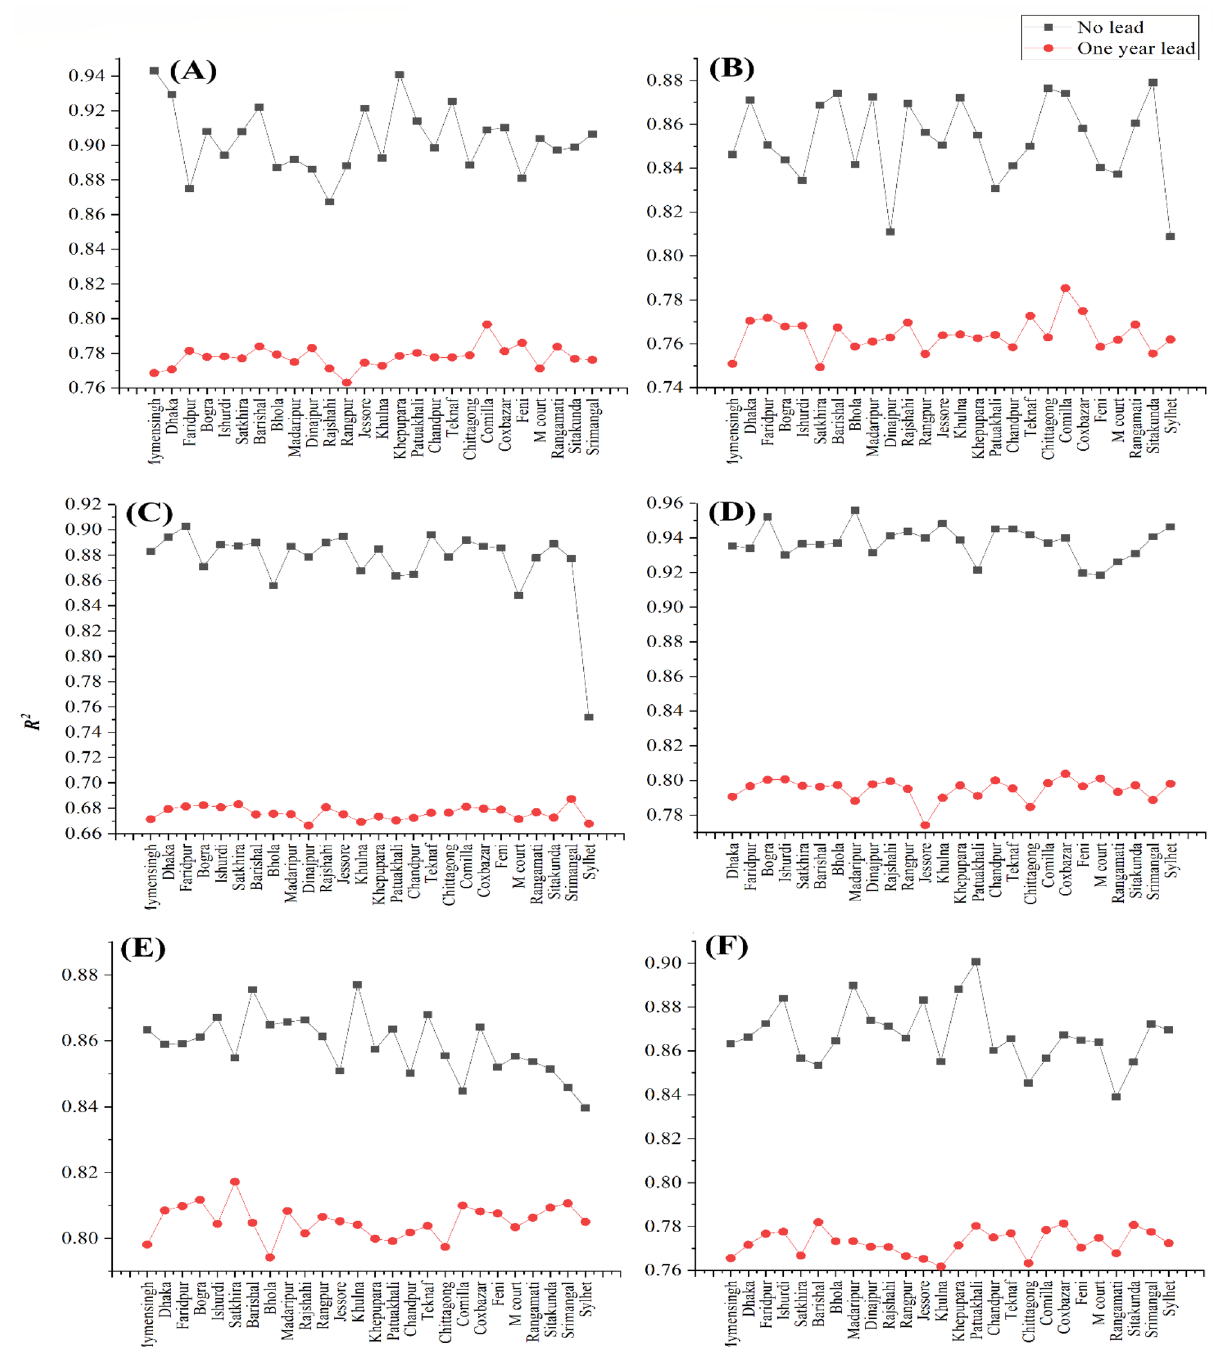
Figure 5. Sensitivity of different stations for predicting MDD of six target stations: A = Sylhet, B = Srimangal, C = Rangpur, D = Mymensingh, E = Dinajpur and F =